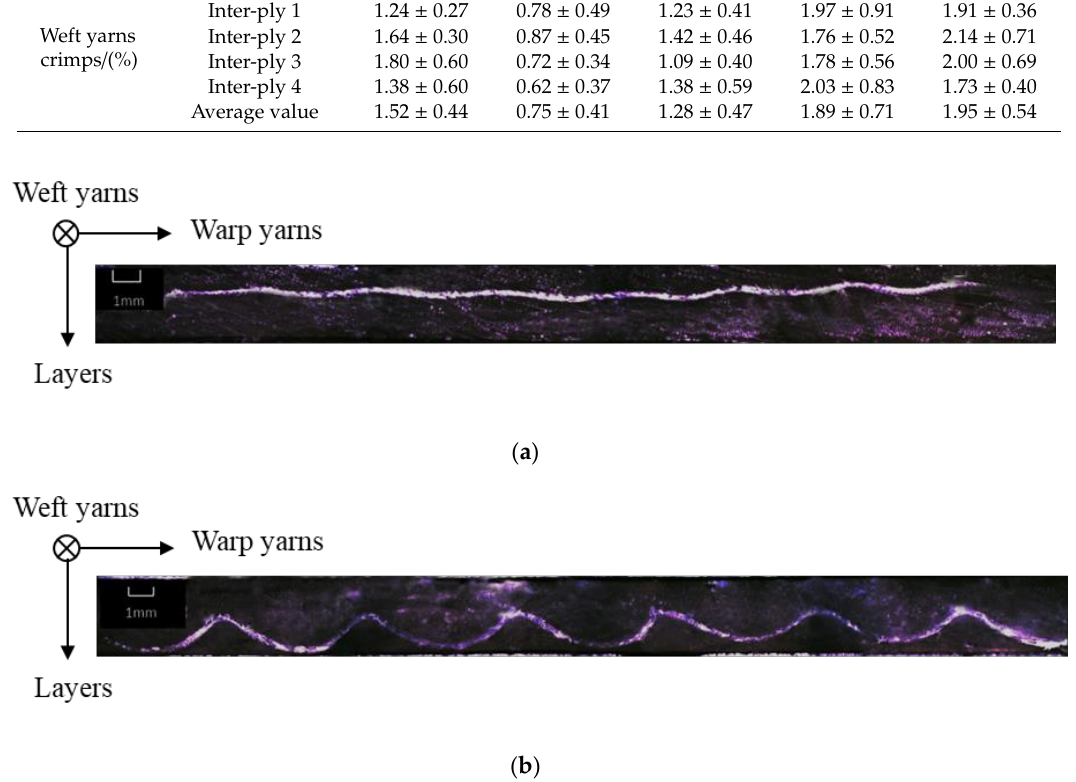
Figure 5. Micro-observation of the cross section of a single binding warp yarn in F2 ( a ) and F4 ( b ) fabrics.